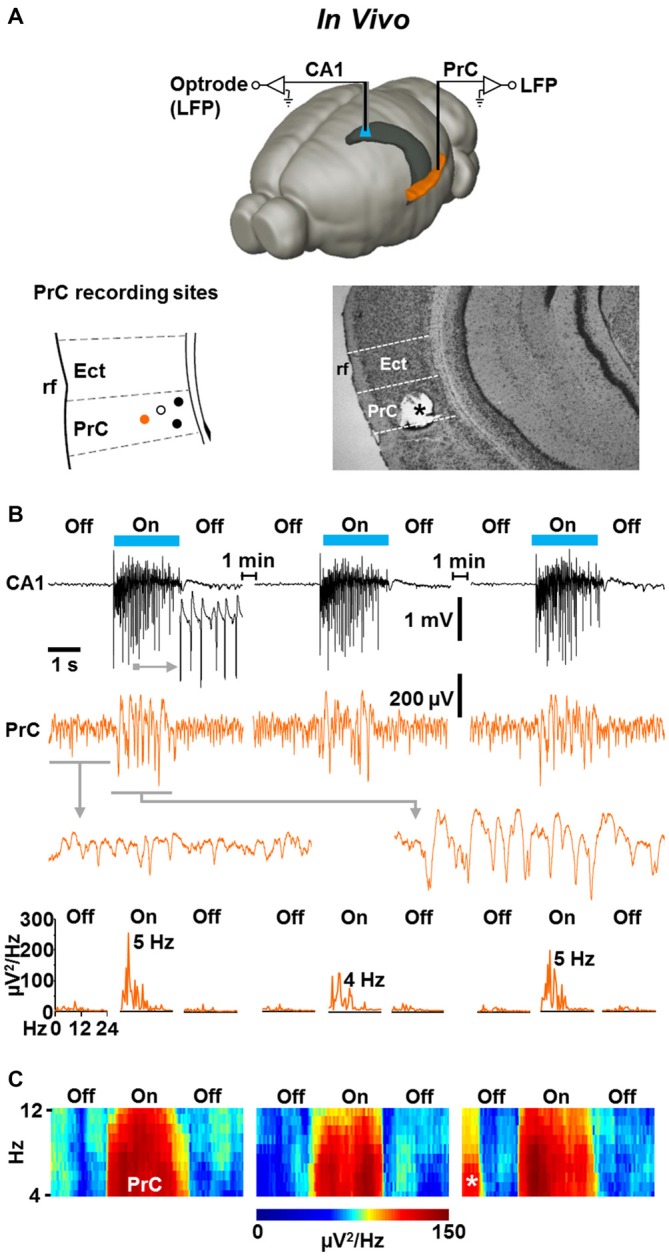
Light-induced fast CA1 network oscillations in NEX-Cre-ChR2 mice are accompanied by concurrent states of enforced theta activity in the ipsilateral PrC. (A) Experimental setting (upper panel) and schematic illustration of PrC recording sites in a part of a coronal brain section (lower left panel; Ect, ectorhinal cortex; rf, rhinal fissure). Closed circles represent recording sites where enforced theta activity was detected. Closed orange circle indicates the recording site in the experiment shown in (B). Open circle marks recording site at which no enforced theta activity was detected. Lower right panel: for verification of PrC recording sites, electrical lesions were set after electrophysiological measurements. Asterisk marks the position of the recording electrode in the experiment shown in (B). (B) Representative recording traces (and enlarged portions of the traces) depicting the CA1 and simultaneous PrC network activities during the repetitive “light off-on-off” protocol used. Lower panels give power spectra for the PrC measurements. (C) Average spectrograms for the PrC recordings marked by closed circles in the lower left panel in (A). Asterisk indicates prominent spontaneous theta activity.